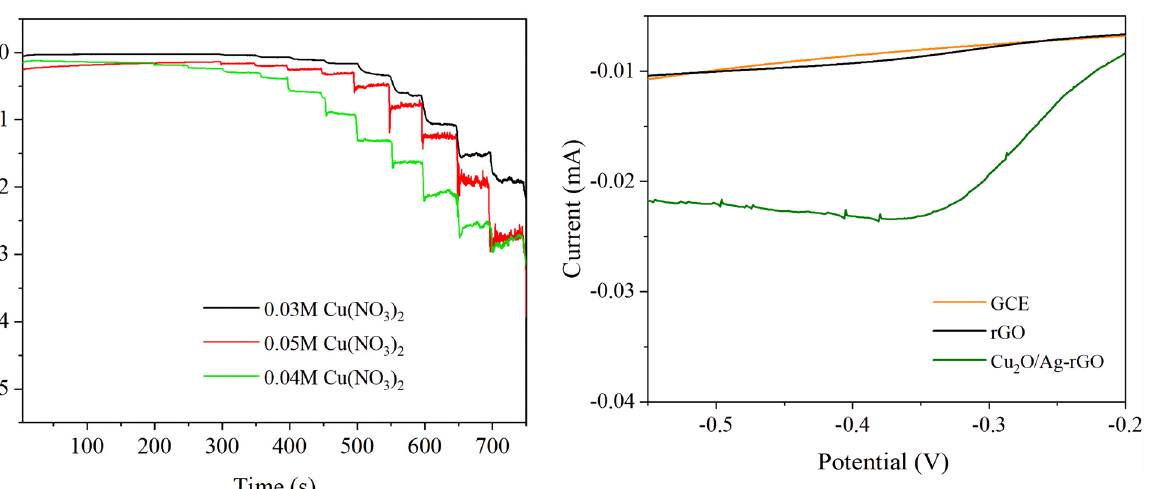
Figure 4: Current – time ( i – t ) curves of the GCE modi fi ed by the Cu 2 O/Ag - rGO nanocomposites prepared by adding di ff erent amounts of Cu ( NO 3 ) 2 into the reaction solution.